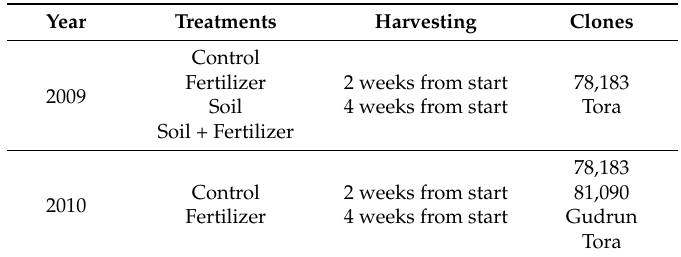
Table 1. Experiment design included four treatments and two clones in 2009 and two treatments and four clones in 2010. The sample size in each treatment combination was 15. The numbers and text in bold are further used in the paper as abbreviations to indicate various